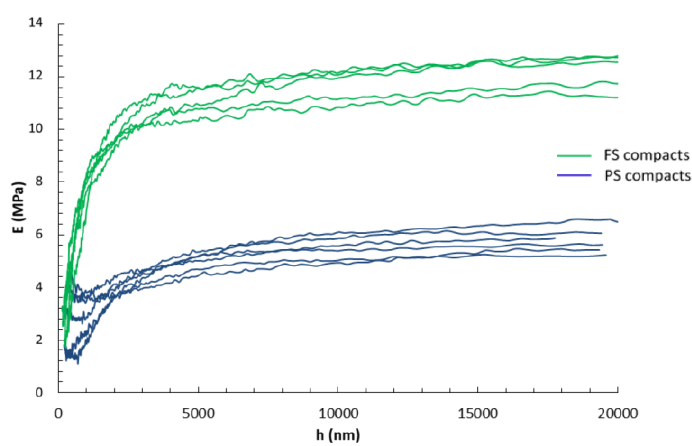
Figure 2. Young’s modulus as measured by CSM versus penetration depth with a 2000-µm diameter sphere for FS (in green) and PS (in blue) compacts.